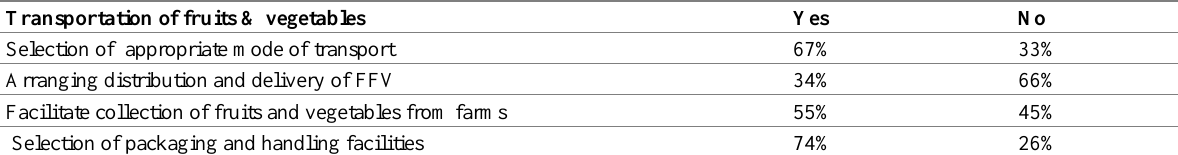
Table 2: Summary of Intermediaries’ Role in Transportation